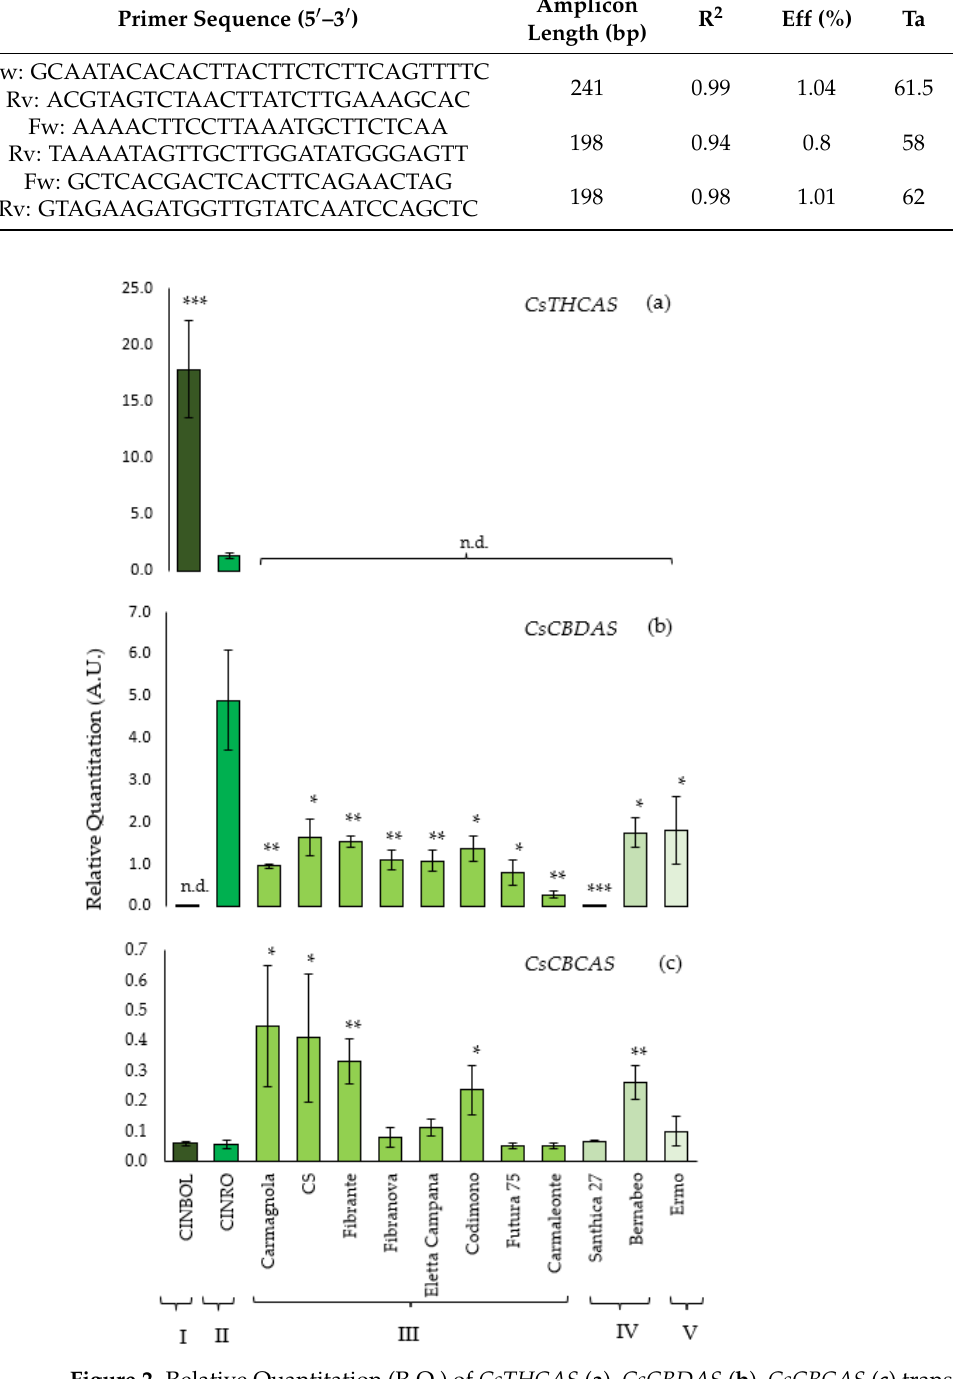
Figure 2. Relative Quantitation (R.Q.) of CsTHCAS ( a ), CsCBDAS ( b ), CsCBCAS ( c ) transcriptional levels in monoecious or female inflorescences. Y axis reports R.Q. expressed in Arbitrary Units (A.U.). Bars represent the standard errors of the mean of three biological replicates ( n = 3). No detectable transcription levels are indicated as n.d. Below, for each genotype the corresponding chemotype is indicated (from I to V). Asterisks indicate Student’s t-test statistically significant differences: * p < 0.05; ** p < 0.01 and *** p < 0.001.